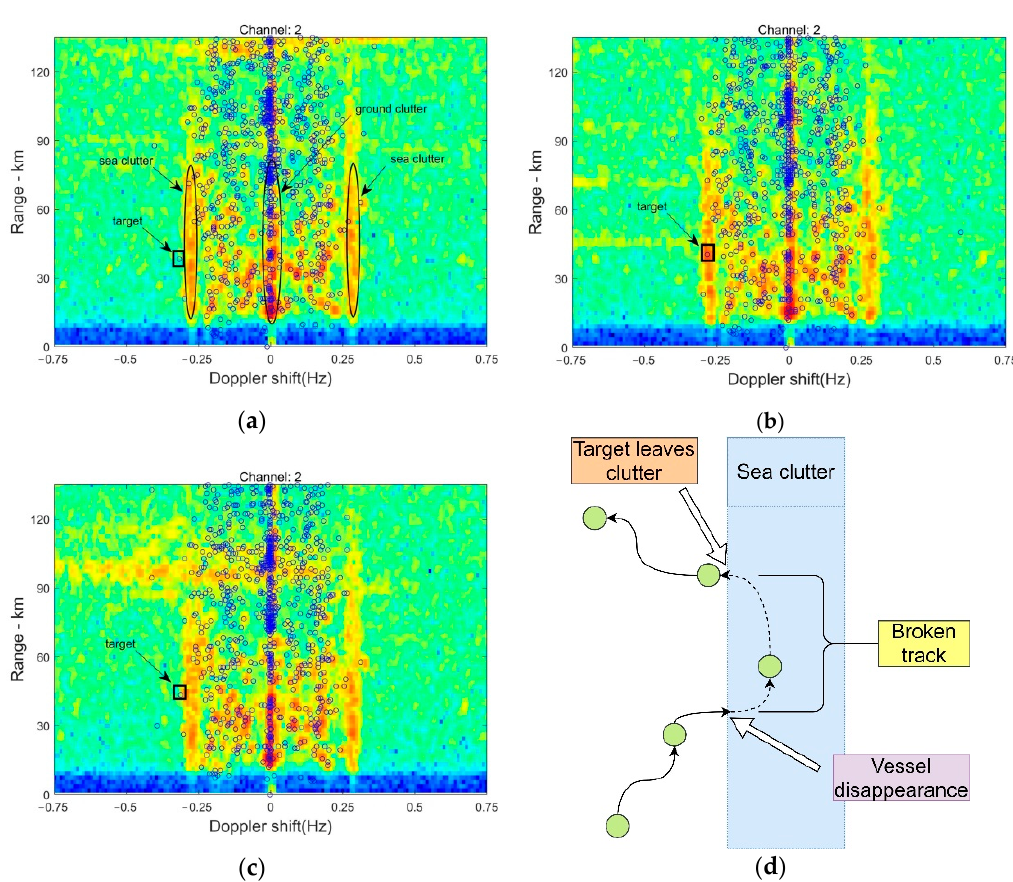
Figure 15. The black ellipses are clutter (sea clutter on both sides and ground clutter in the middle), the blue circles are the vessels detected by AIS, and the black box is the target vessel. ( a ) The target vessel is sailing toward the sea clutter zone. ( b ) The target vessel is covered by the clutter region. ( c ) The target vessel is leaving the sea clutter zone. ( d ). Schematic diagram of the target vessel entering and leaving the sea clutter.